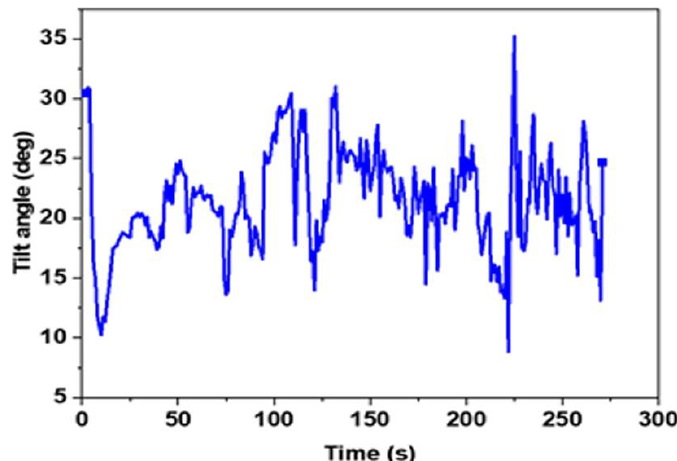
Figure 8. Trunk back bending